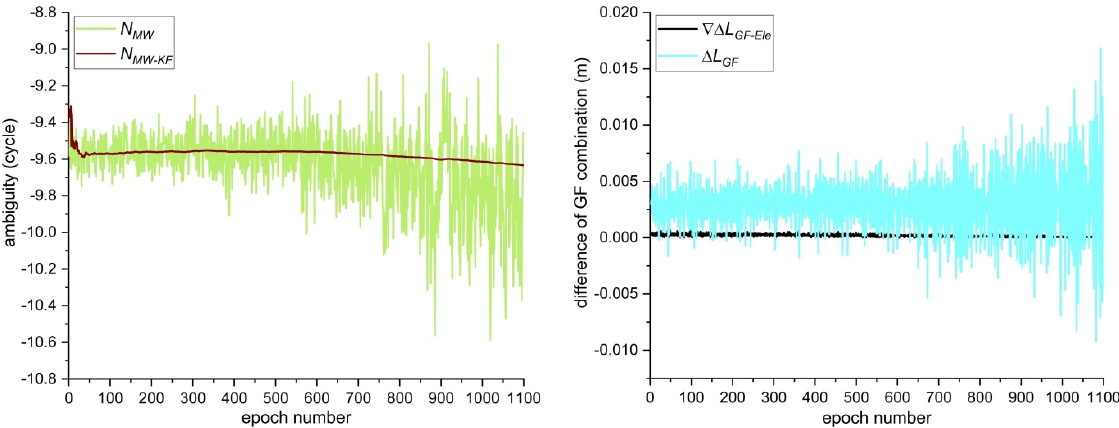
Figure 14. Wide-lane ambiguity and second-order difference GF combination sequence of satellite G10 under dynamic sea environment.